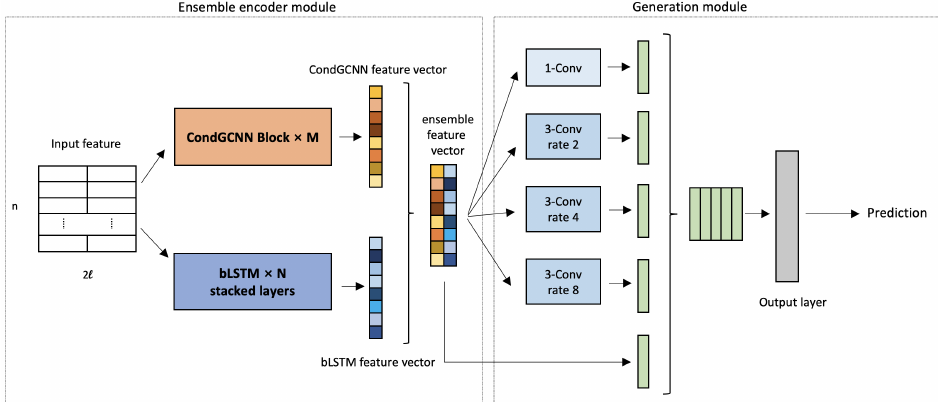
Figure 2. Our ensemble learning with ASP networks framework contains ensemble encoder module and generation module. For ensemble encoder, we use several CondGCNN blocks and bLSTM layers in the networks; for generation module, a modified ASPP is applied in the